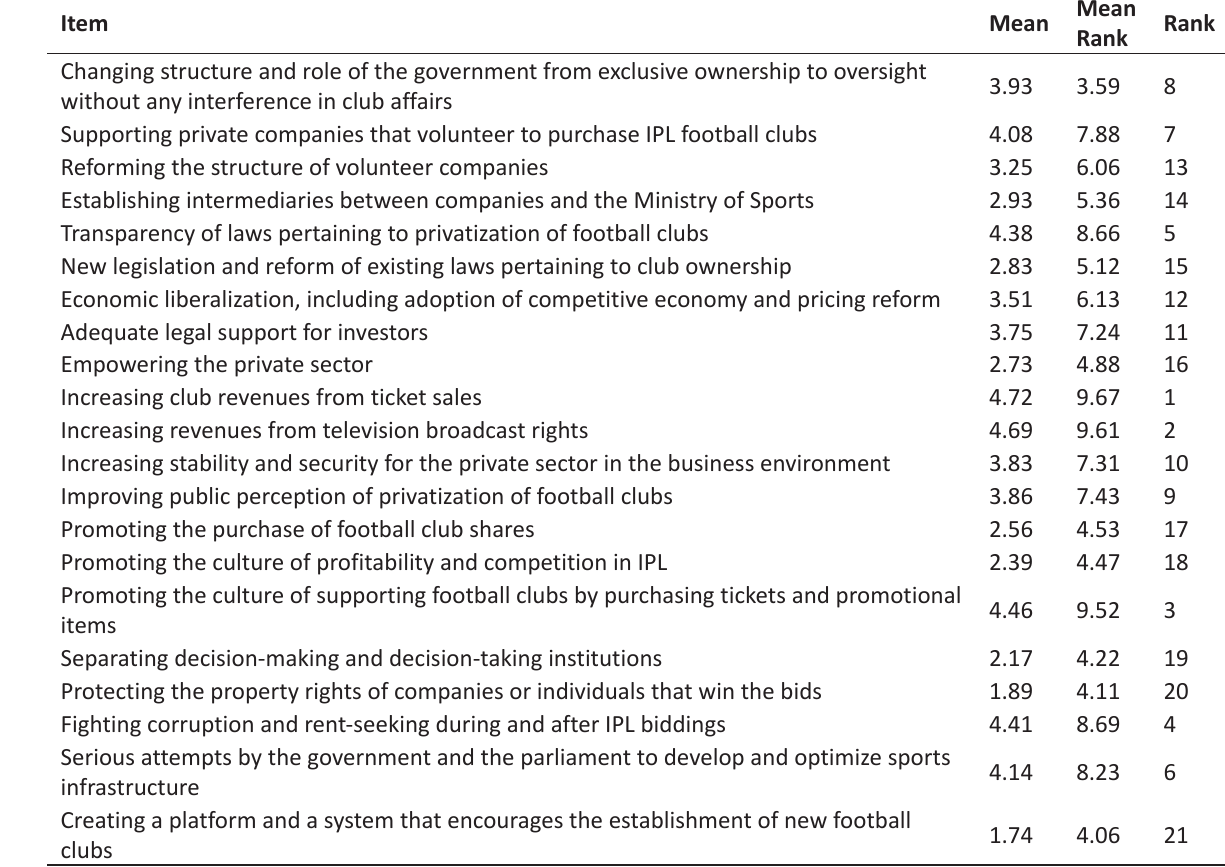
Table 4. The results of Freidman test for ranking privatization requirements by their importance